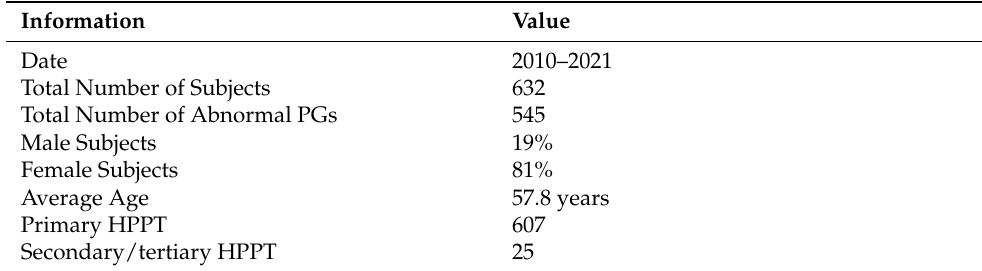
Table 1. Characteristics of the study’s